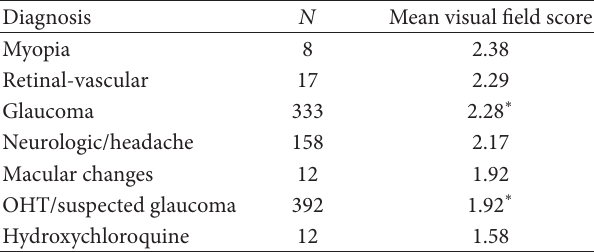
T 4: Mean visual �eld score by